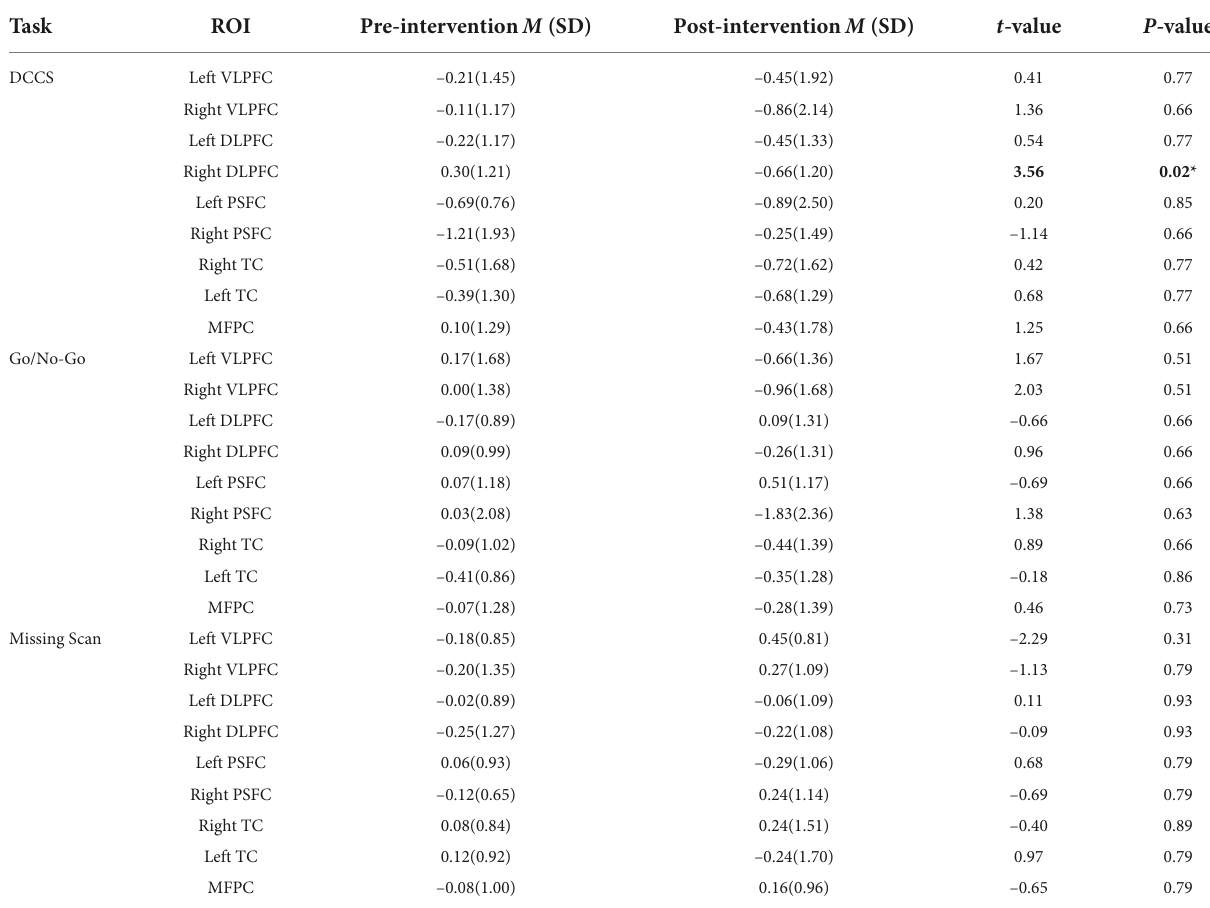
TABLE 7 Comparison of increases in HbR before and after the intervention for boys ( N =